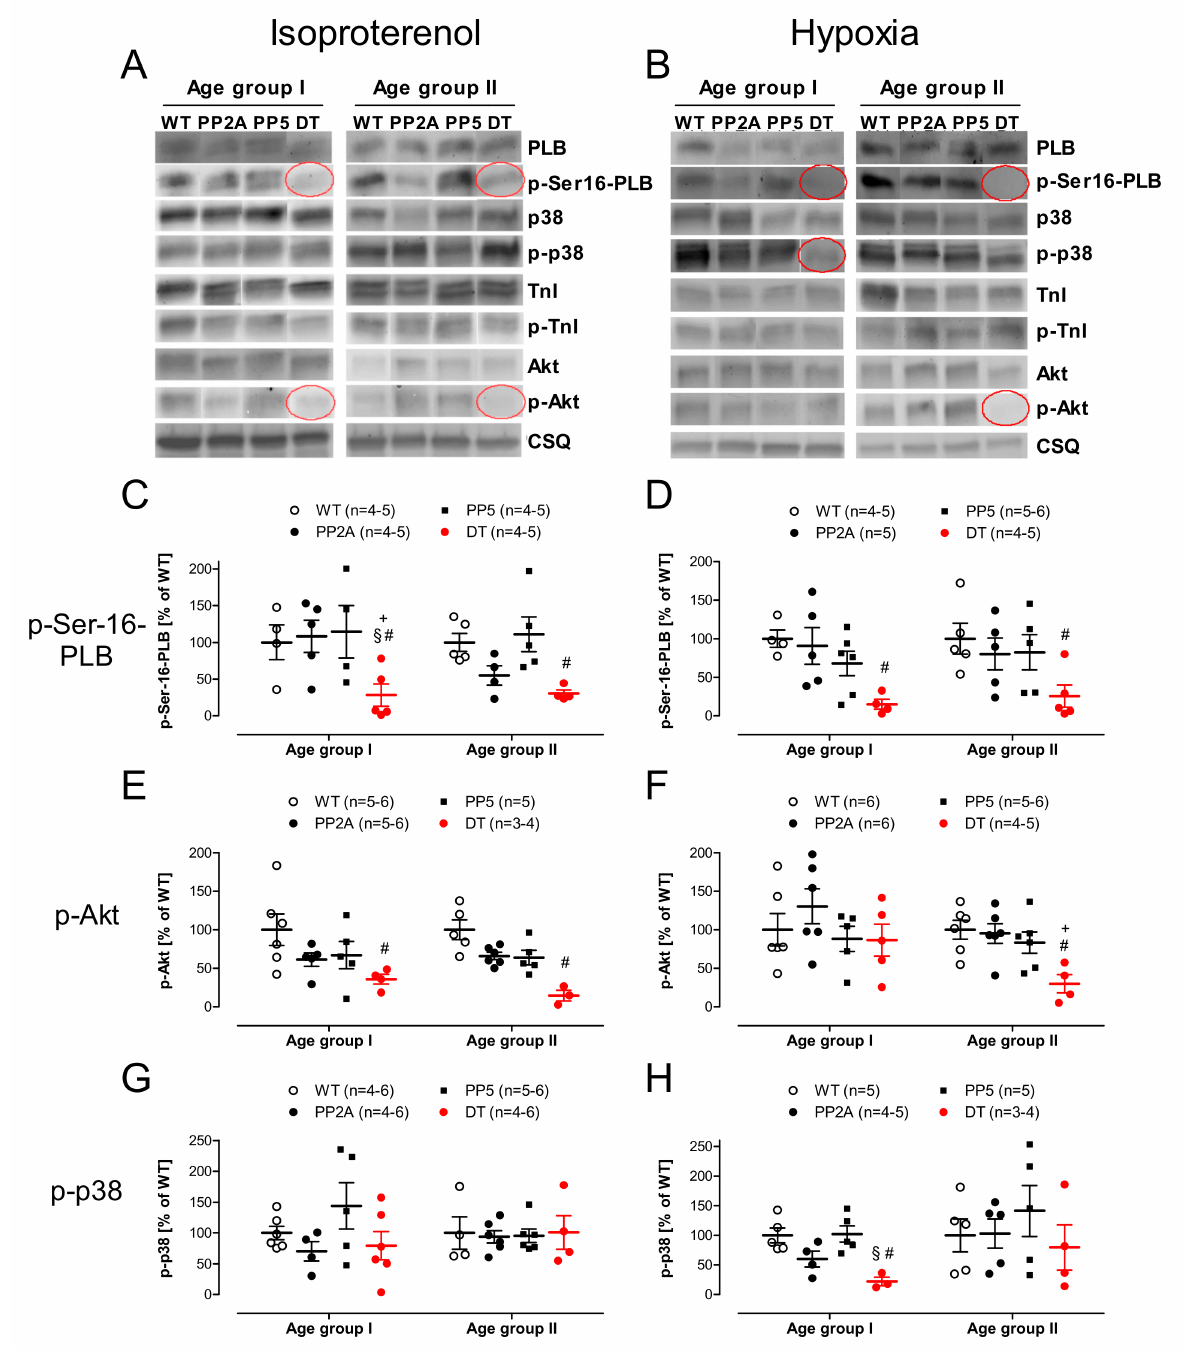
Figure 10. Phosphorylation state of regulatory proteins in atria freeze clamped directly after isoproterenol and directly after hypoxia of young (age group I) and middle-age (age group II) mice. ( A ): Original Western blots after isoproterenol, Calsequestrin (CSQ) as loading control; ( B ): Original Western blots after hypoxia; Calsequestrin (CSQ) as loading control; ( C ): Serine-16 phosphorylation of phospholamban (p-Ser-16-PLB) after isoproterenol, ( D ): Serine-16 phosphorylation of phospholamban after hypoxia; ( E ): Phospho-Akt (p-Akt) after isoproterenol; ( F ): Phospho-Akt after hypoxia; ( G ); Phospho- p38-MAPK (p-p38) after isoproterenol; ( H ): Phospho-p38-MAPK after hypoxia; # p < 0.05 vs. WT; + p < 0.05 vs. PP2A; § p < 0.05 vs. PP5; n =